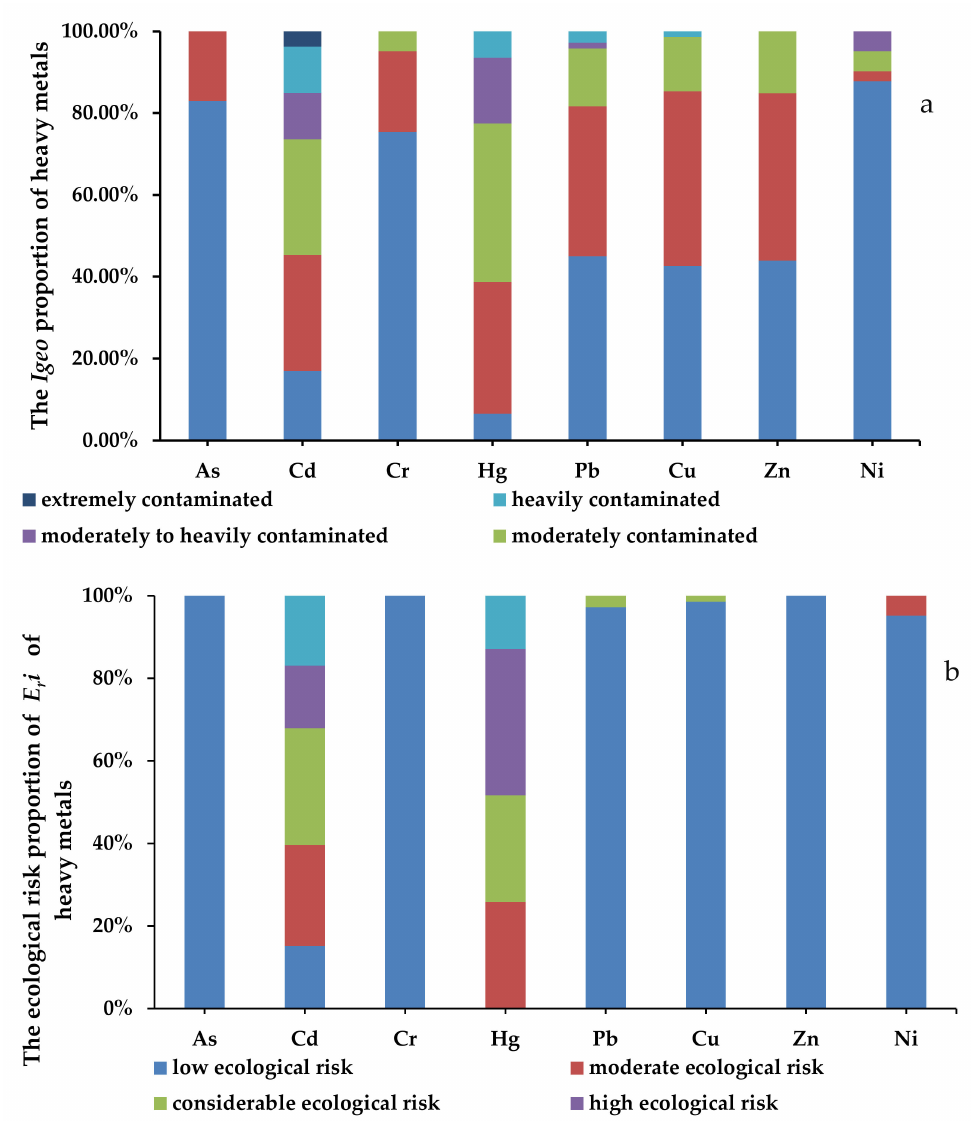
Figure 4. The proportion of the geoaccumulation index (Igeo) and ecological risk ( E i r ) of heavy metals in urban soils around China. ( a ): The proportion of Igeo heavy metals in urban soils around China. ( b ): The proportion of E i r heavy metals in urban soils around